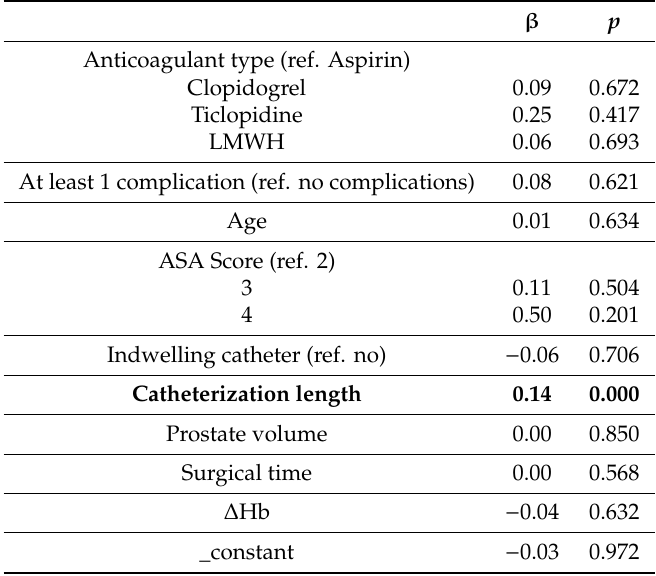
Table 4. Poisson regression on postoperative